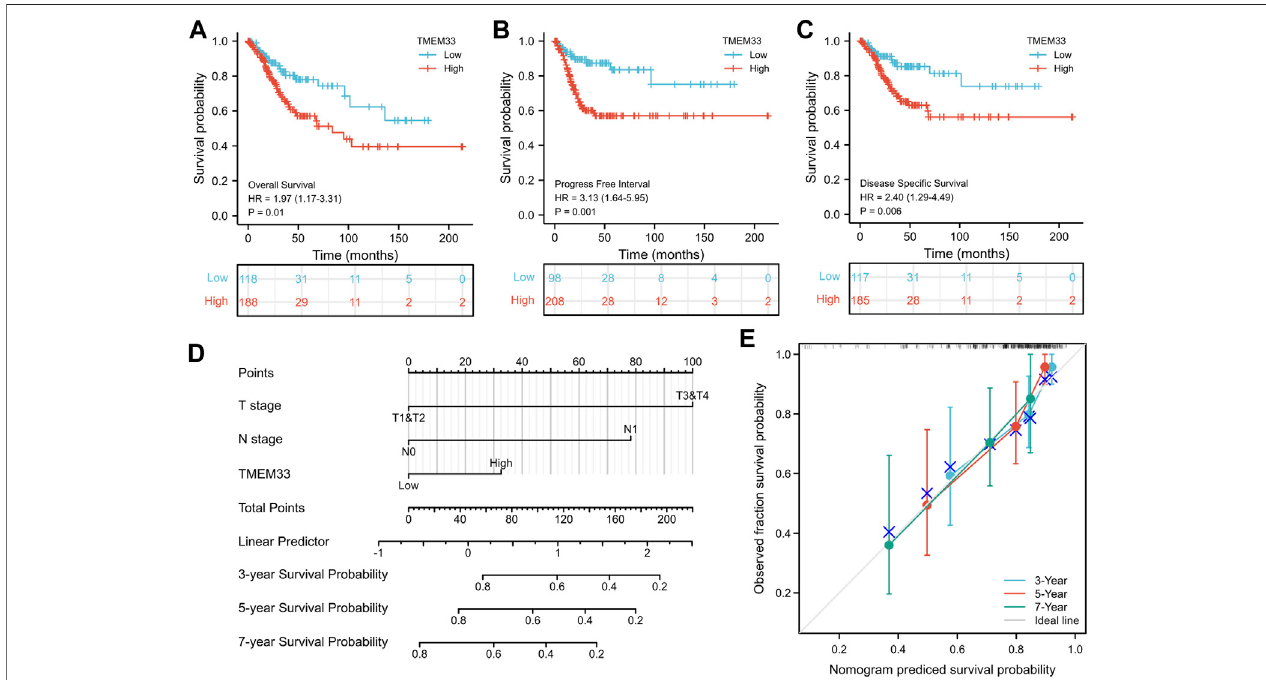
FIGURE 2 | Prognostic value of TMEM33 in CESC based on the TCGA database. Kaplan-Meier analysis comparing overall survival (A) , progression-free interval (B) ,anddisease-speci fi csurvival (C) betweenlow-andhigh-TMEM33expressiongroups. (D) Anomogramforpredictingprobabilityofpatientswith3-, fi ve-and7-years overall survival. (E) Calibration plots validating the ef fi ciency of nomograms for overall survival.